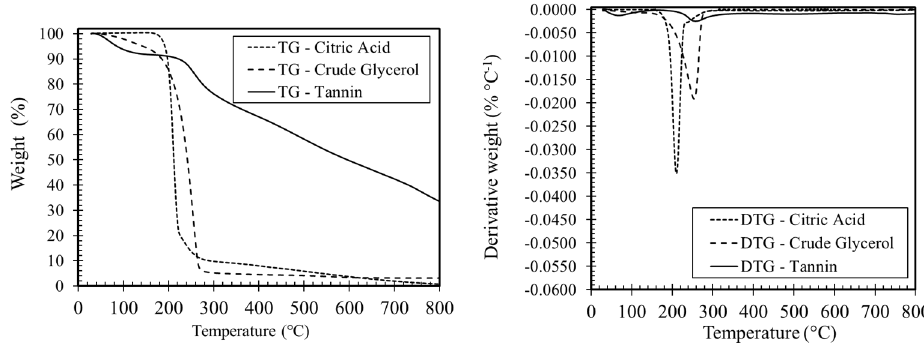
Figure 4. TG and DTG curves of citric acid, crude glycerol, and condensed tannin.